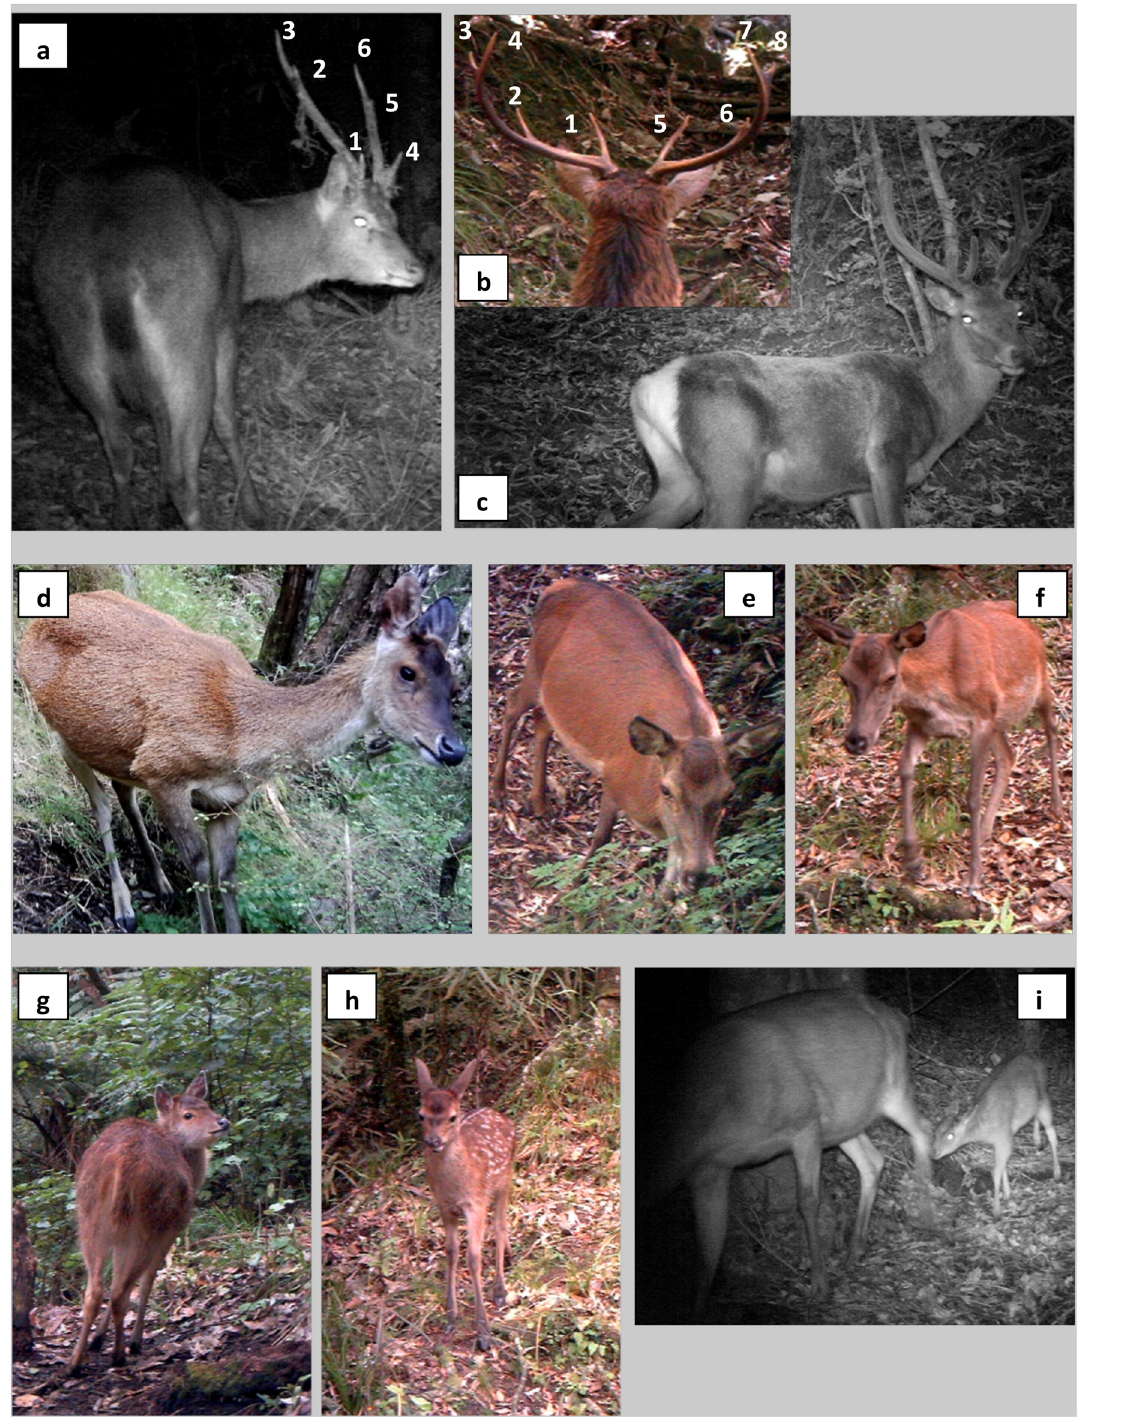
Fig 2. Distinguishing features of rusa deer and red deer. Antlers of mature rusa deer males typically have a maximum of six points and a lyre shape (a), whereas red deer antlers often exceed six points (b). Rusa deer have a long slender tail, slightly bushy towards the tip, and a light-coloured rump patch (a) compared with red deer, which have a short tail and distinct white rump patch (c). The face of rusa deer is shorter, as are the ears, which have rounded tips (d) compared with the red deer ’ s elongate face and longer ears with pointed tips (e, f). A dark strip of hair along the spine (e) and light-coloured hair on the belly (f) are further characteristics of red deer that are less pronounced in rusa deer (d). White spots are absent on the coat of rusa deer juveniles (g) but